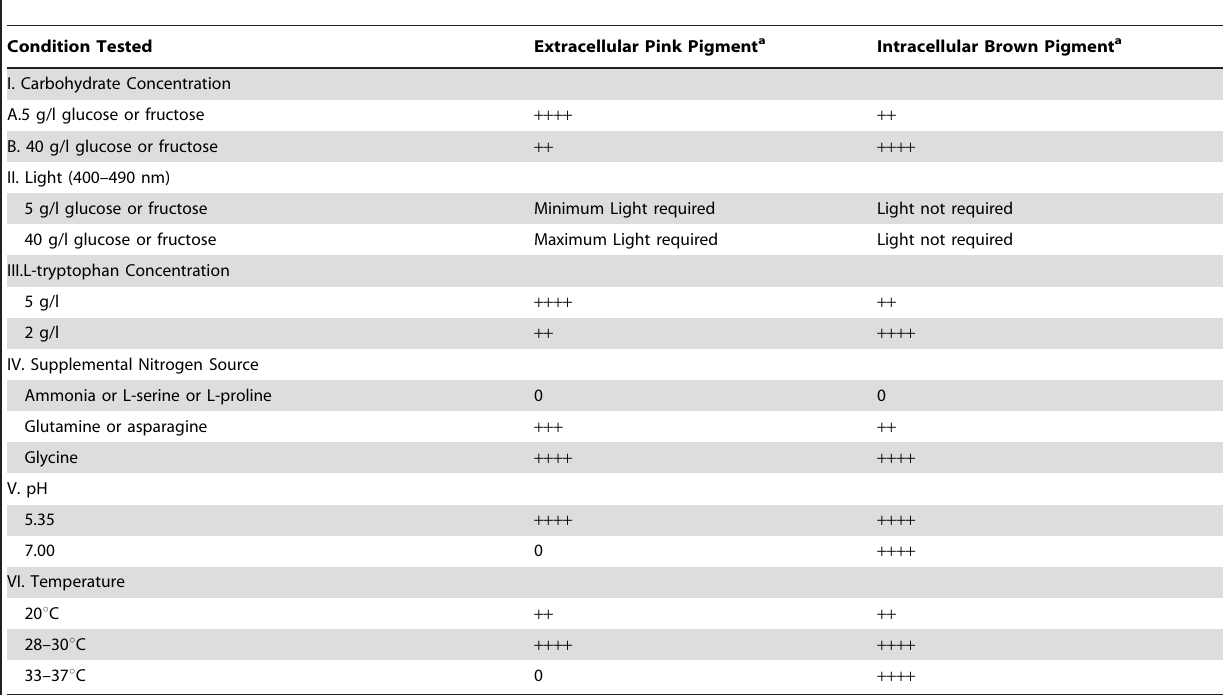
Table 1. Optimum conditions for the production of the extracellular pink and intracellular brown pigments formed by Cryptococcus spp. from